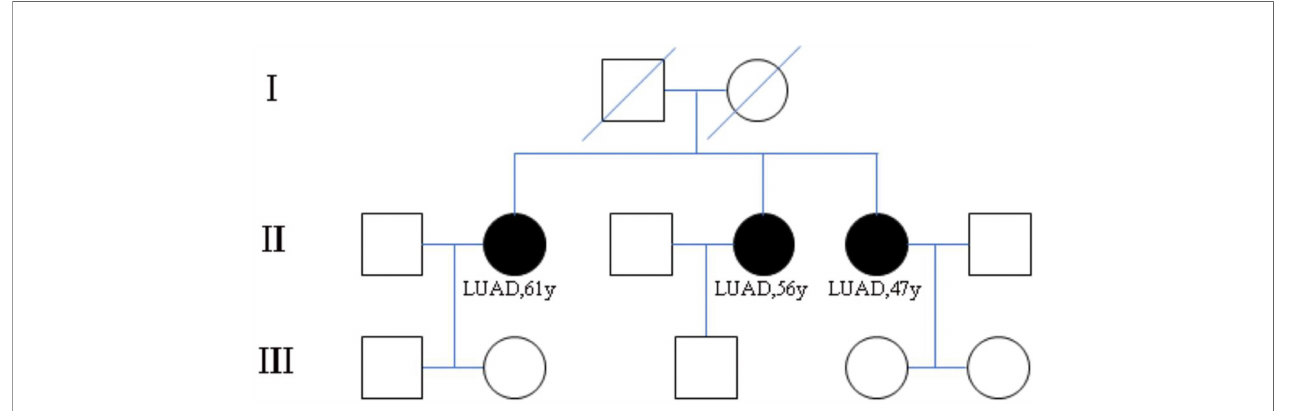
FIGURE 1 | Pedigree of family (case 3) with multiple cases of lung adenocarcinoma. II-2, II-4, II-5 are sisters and have been diagnosed as lung adenocarcinoma. I-1 and I-2 are their parents and have passed away. The other members of this family have no history of lung